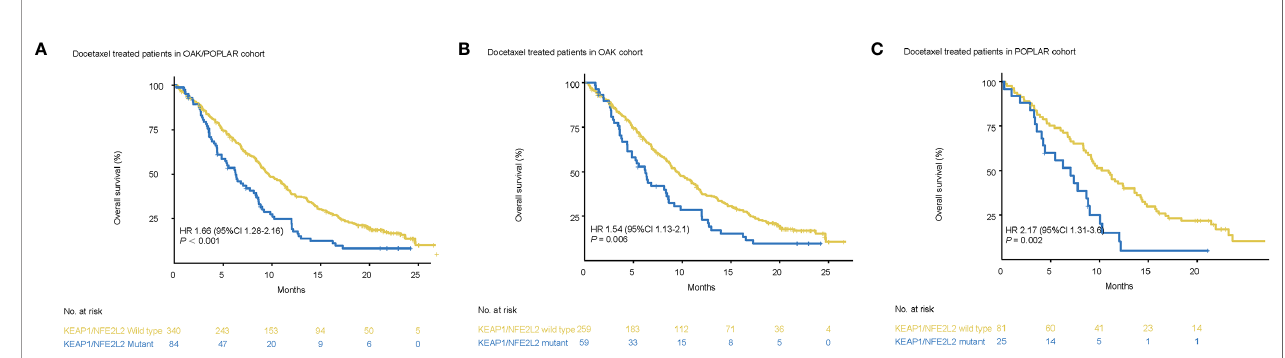
FIGURE 4 | Survival analyses in the OAK/POPLAR-docetaxel cohorts. (A) Kaplan – Meier curves of overall survival (OS) in the docetaxel treated patients with or without KEAP1/NFE2L2 mutations in the OAK/POPLAR cohort. (B) Kaplan – Meier curves of OS in the docetaxel treated patients with or without KEAP1/NFE2L2 mutations in the OAK cohort. (C) Kaplan – Meier curves of OS in the docetaxel treated patients with or without KEAP1/NFE2L2 mutations in the